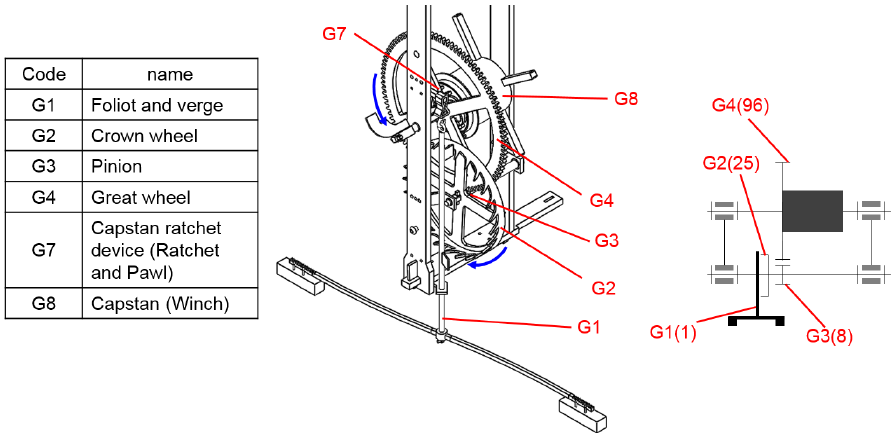
Figure 2. Going train structure of the Cotehele clock (N2).